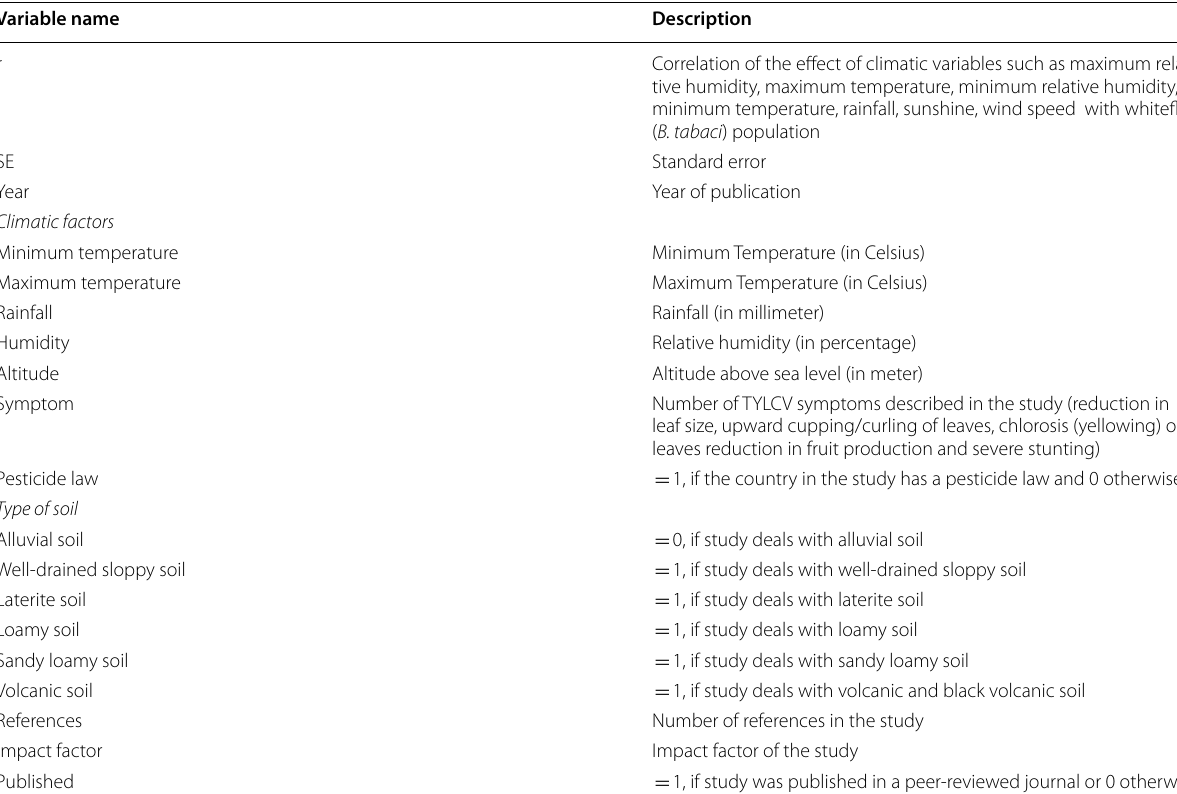
Table 1 Variable Description for the